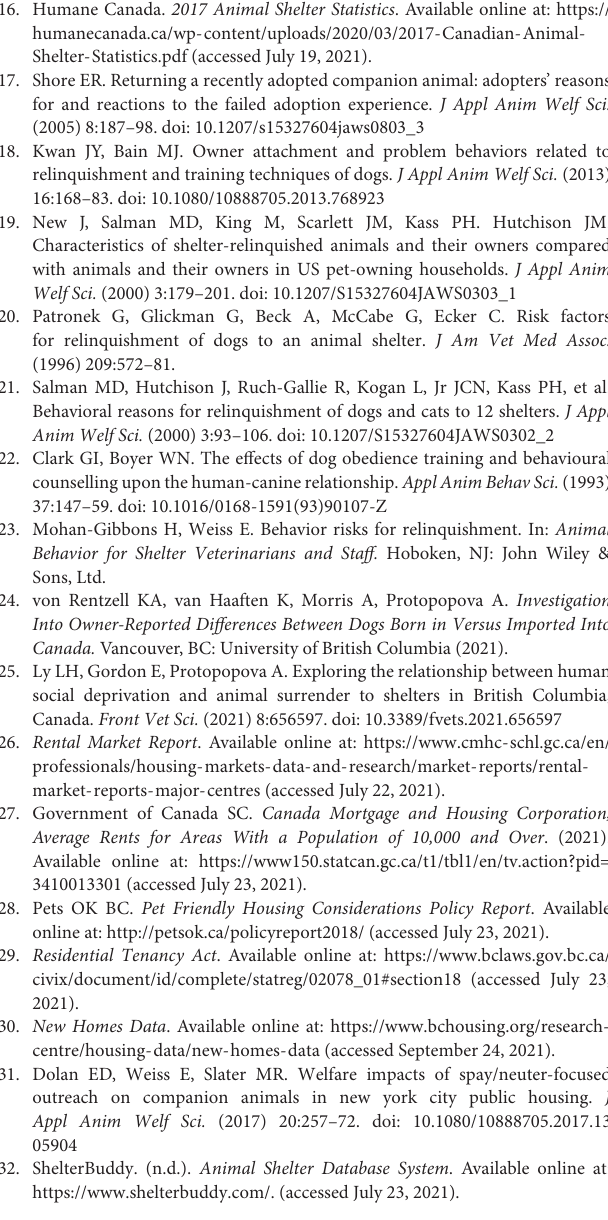
Supplementary Data Sheet 1 | Eagan et al. Code. Github link for access to R code used to analyze the reasons for guardian-relinquishment of dogs to shelters: animal and regional predictors in British Columbia,